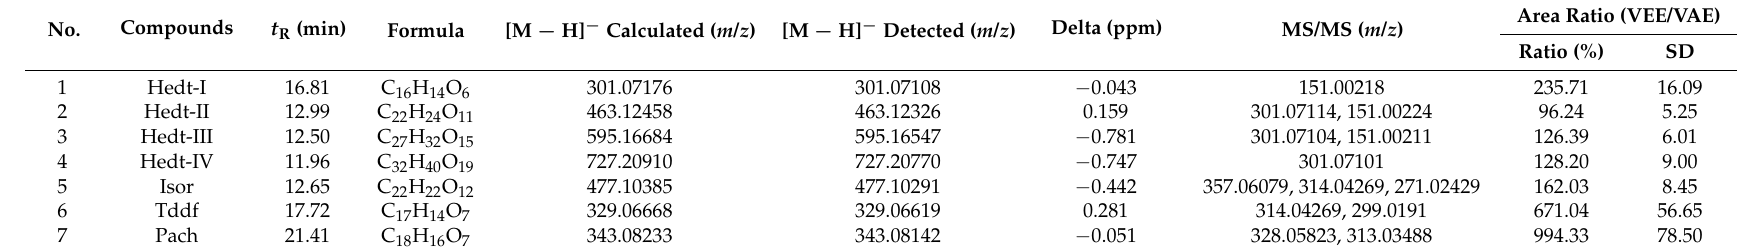
Table 1. The composition of flavonoids in Viscum coloratum